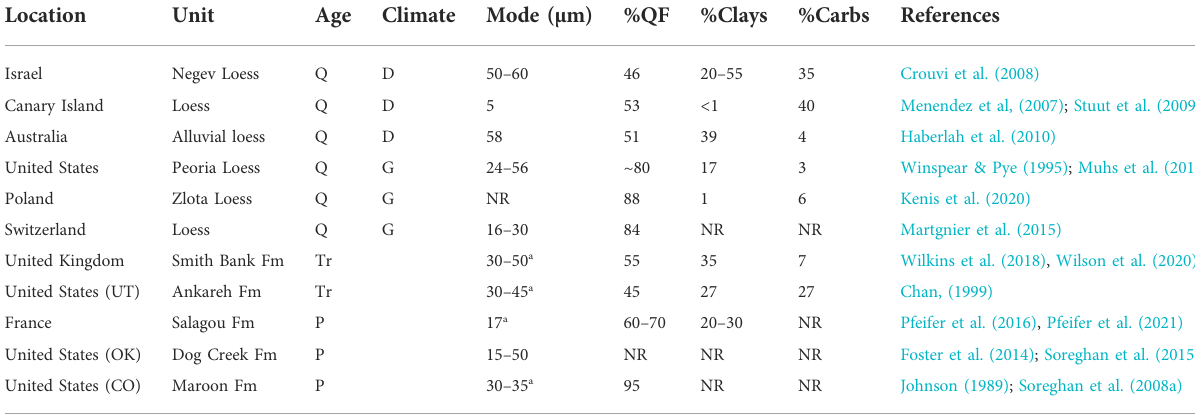
TABLE 3 Particle size and mineralogy of selected loess